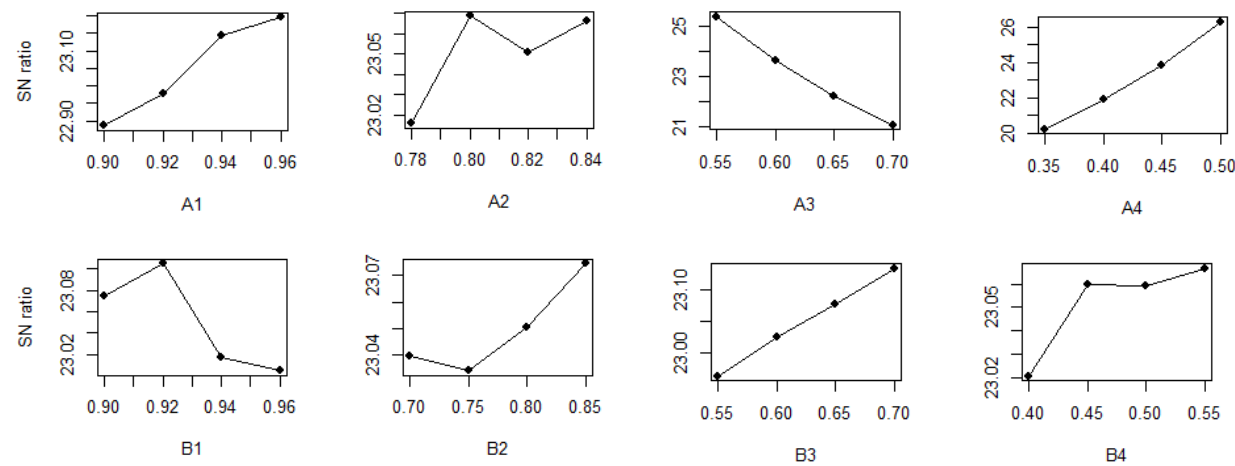
Figure 4. Effect of A and B factors on the variability of SPS due to noise factors.